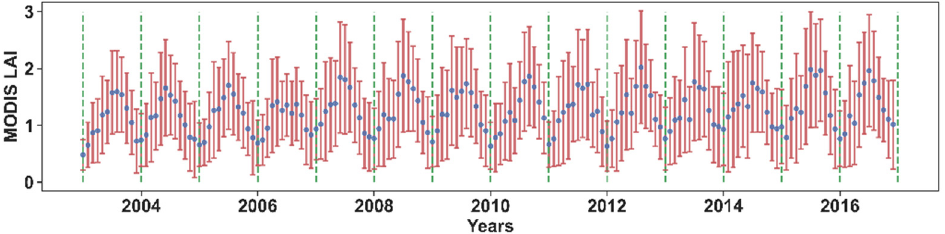
Figure 2. The mean curve of MODIS LAI in Henan Province from 2003 to 2016. The red line is the error bars plotted using standard deviation; blue dots represent the mean; between the two green dotted lines is the LAI for one